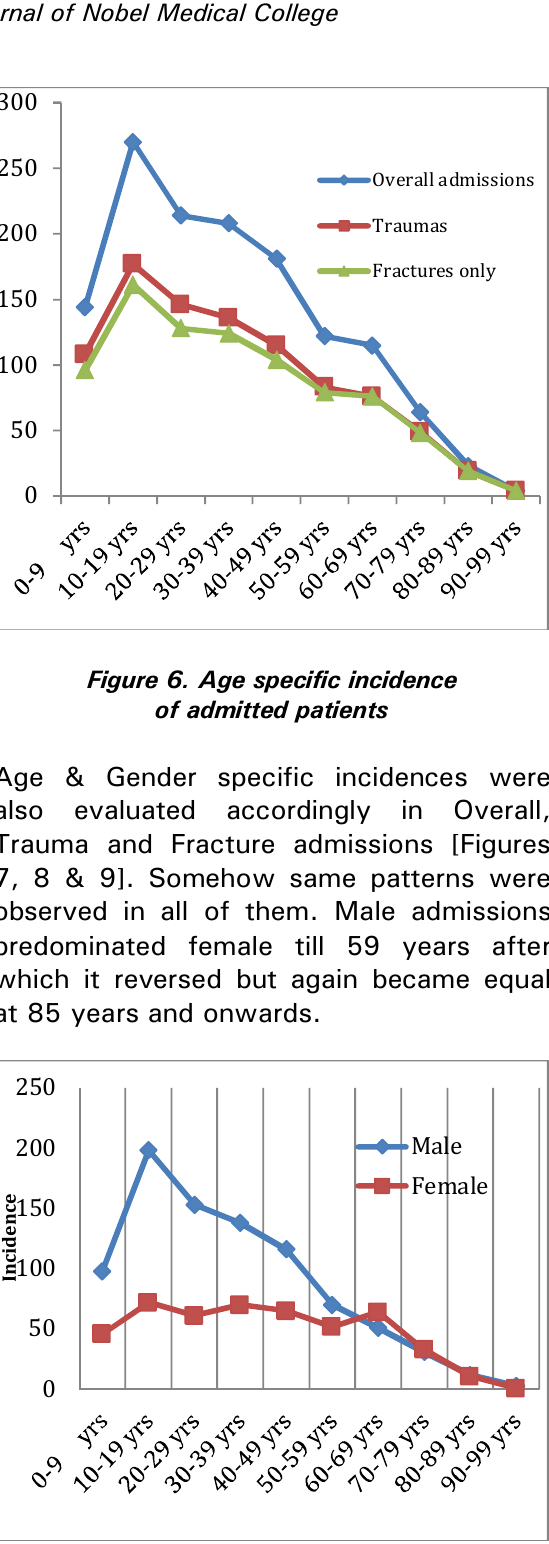
Figure7. Age & Gender specific incidence in overall